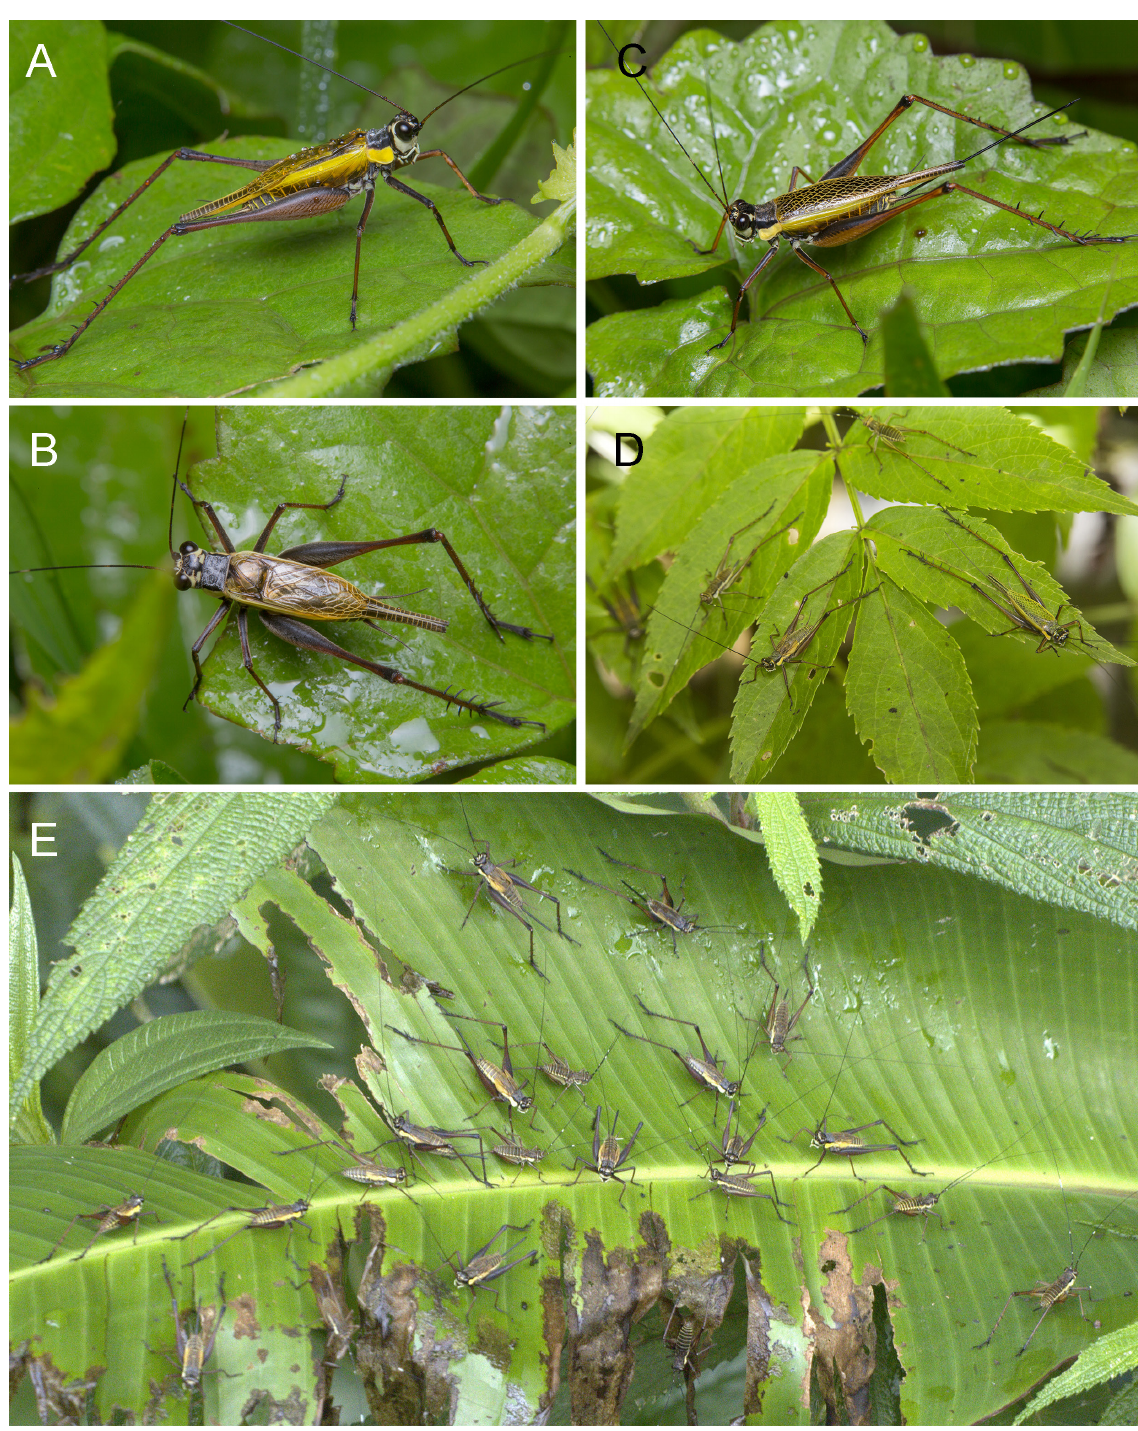
Fig. 28. Nisitrus musicus Ingrisch, 1987 in its natural environment. A–B . Adult ♂♂. C . Adult ♀. D–E . Aggregations of adults and nymphs. Photograph source and credits: iNaturalist; Marcus Ng (A–D), Kaitlyn O’Brien